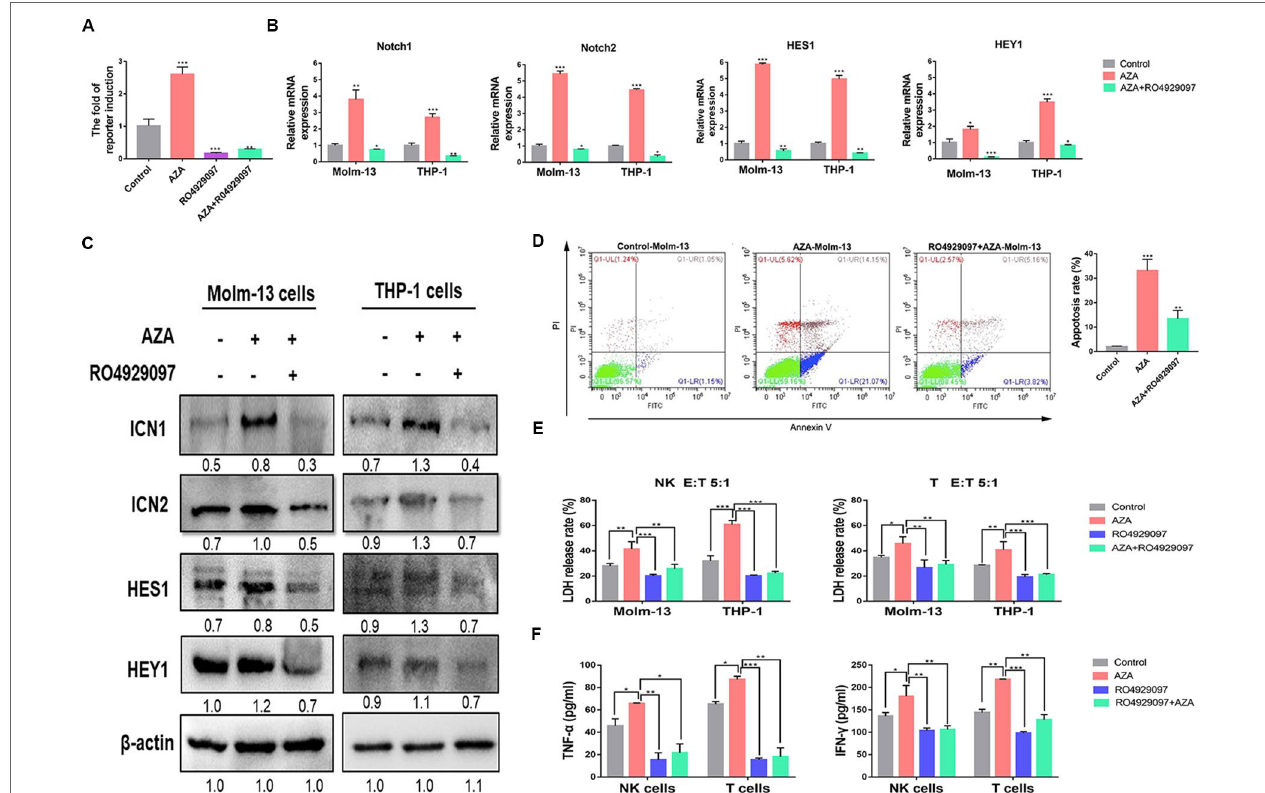
FIgUrE 6 | Azelaic acid (AZA) exerts anti-leukemic effect by activating the Notch signaling pathway. (A) Notch responsive elements were transfected into 293T cells after 24 h. Cells were then treated with 10 μM AZA, 10 μM RO4929097, and combination for 24 h, the Notch signaling reporter assay was measured by dual luciferase reporter activity. (B) Validation of the RNA expression of Notch1 and Notch2, the downstream target genes HES1 and HEY1 in Molm-13 and THP-1 cells by qPCR. (c) The protein expression level of ICN1, ICN2, HEY1, and HES1 in acute myeloid leukemia (AML) cell lines after treatment of AZA and RO4929097 and their detection by western blot. ImageJ was used for the densitometric analysis. Data represent means ± SD. (D) Molm-13 cells were pretreated with 10 μM RO4939097 for 24 h, and then treated with 10 μM AZA for another 24 h. Cells were collected for apoptosis analysis. (E) NK cells and T cells were pretreated with 10 μM AZA, 10 μM RO4929097, and combination for 24h before co-culture with THP-1 cell and Molm-13 cells at an E:T ratio of 5:1. The cytotoxicity of NK and T was determined by detecting the LDH release rate. (F) NK and T cells were pre-treated with AZA and RO4929097, then co-cultured with THP-1 cell at an E:T ratio of 3:1 for 4 h. The level of TNF-α and IFN-γ in the supernatant was measured by ELISA. A Total of three independent experiments were performed. *P < 0.05, **P < 0.01,***P <